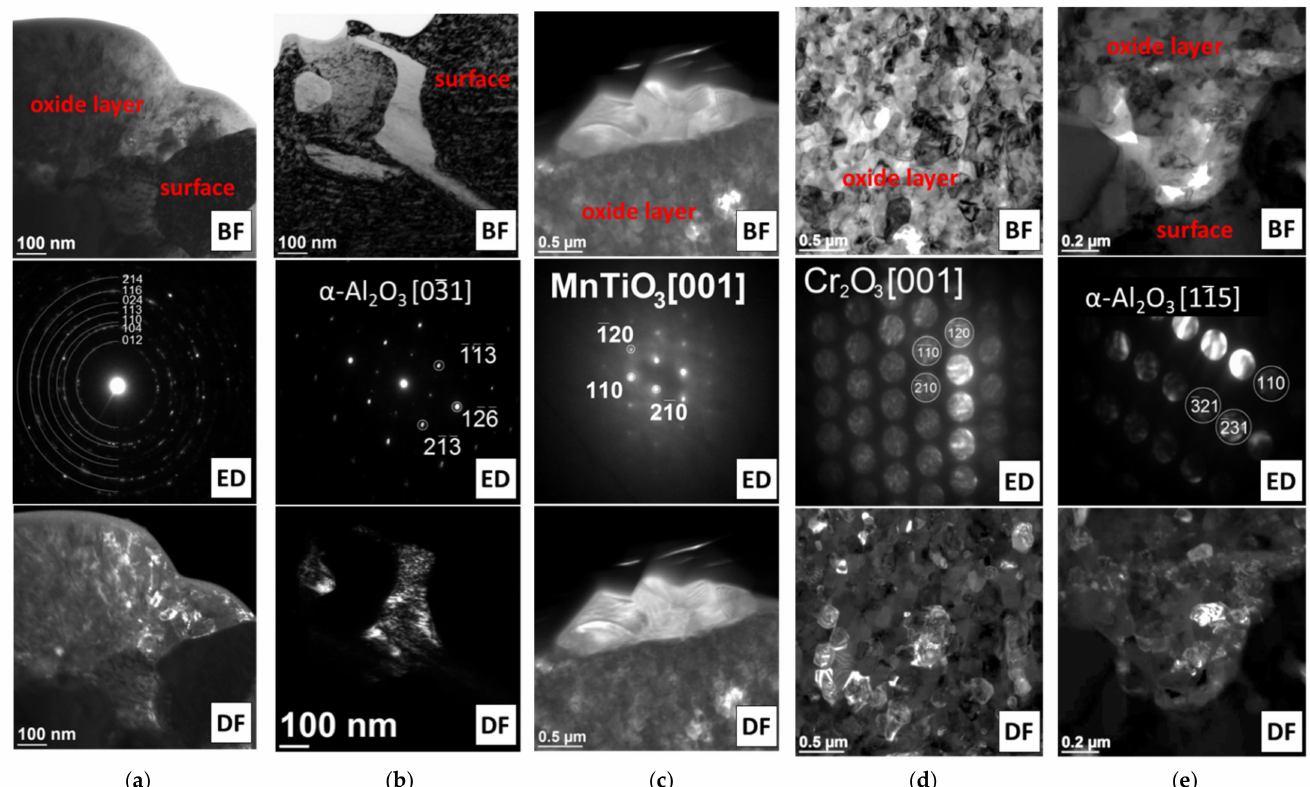
Figure 6. Phase identification of oxides formed during oxidation of Inconel 740H alloy in a steam atmosphere at 750 ◦ C. TEM: ( a , b ) 100 h and ( c – e ) 2000 h.